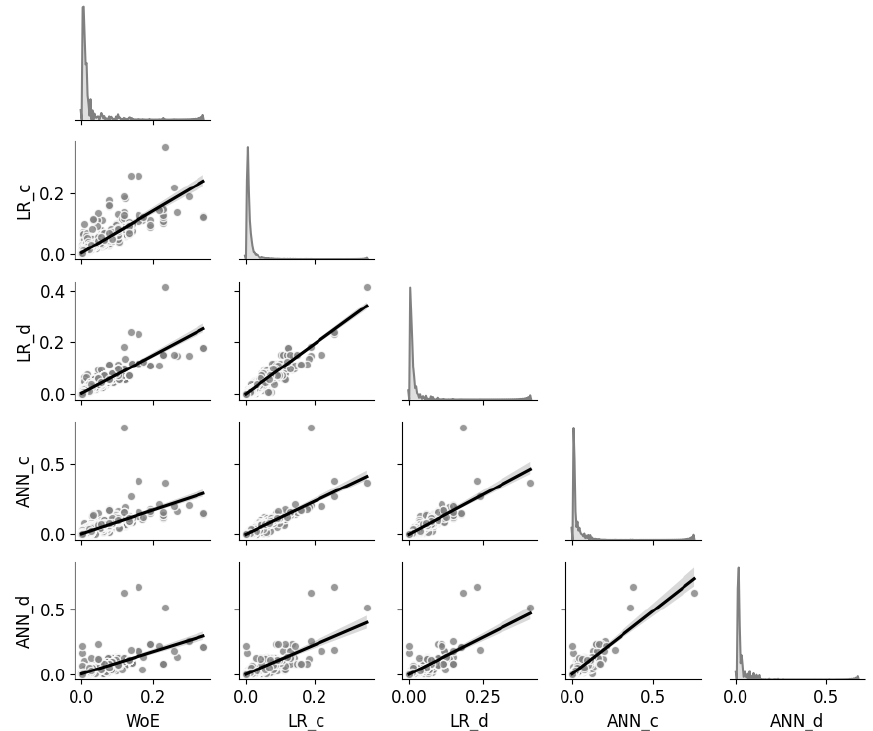
Figure 11. Pairwise comparison of the predicted landslide susceptibility